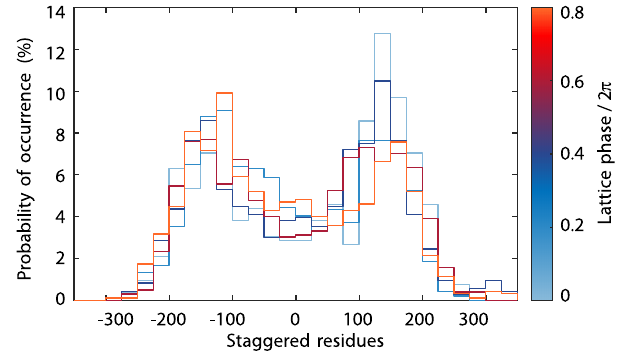
FIG. 9. Lattice-phase resolved histogram. The histogram of local density-wave order of Fig. 2(c) with separate analysis for the different lattice phases (color coded) still shows the double- peak structure reflecting the spontaneous symmetry breaking.